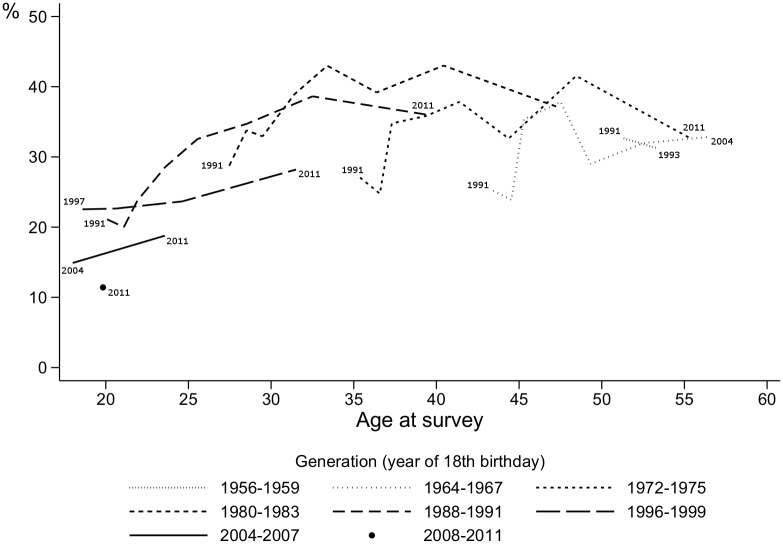
Percentage of participants reporting more than 10 male partners in the previous 12 months.Surveys in 1991–2011, respondents aged 18–59. Reading: 22.5% of the respondents from the 1996–1999 generation reported more than 10 male partners in the previous 12 months when their mean age was 18.6 years (i.e., when they were surveyed in 1997). Lines are drawn only when the generation is composed of at least 30 respondents.